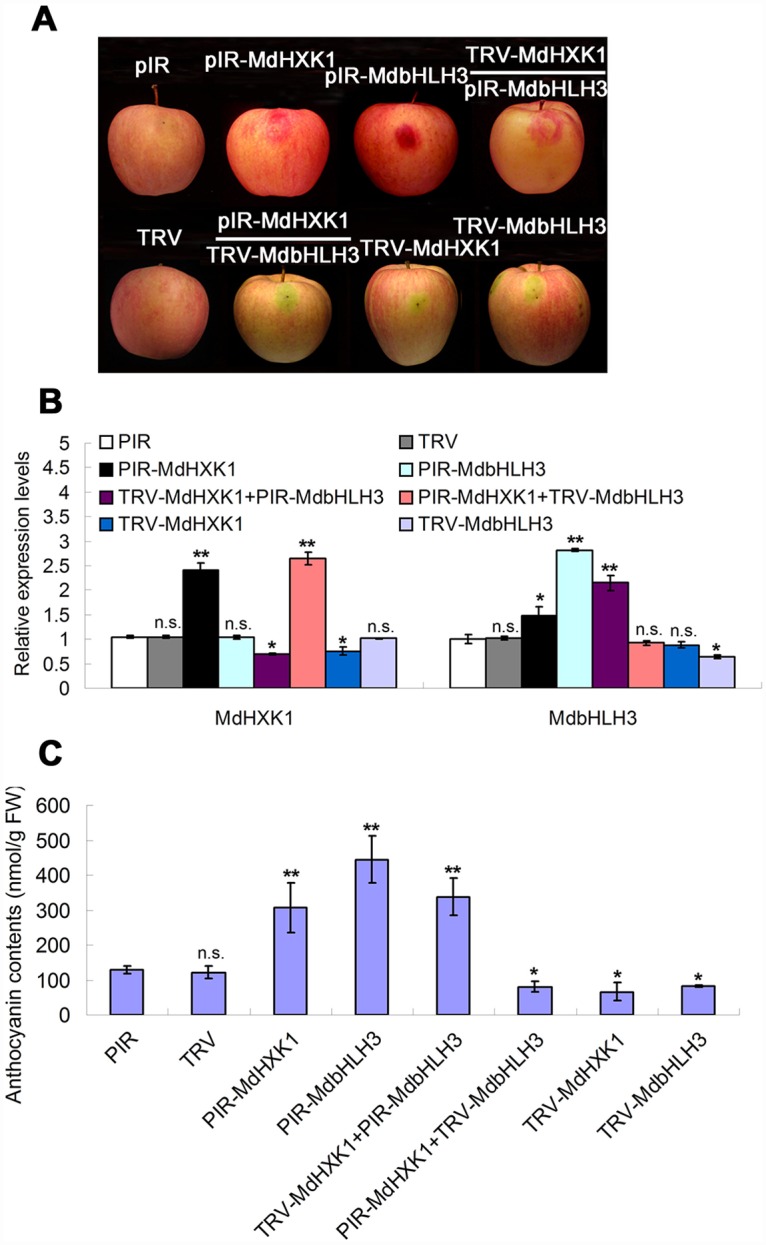
Transient expression of MdHXK1 and MdbHLH3 via the viral vector-based transformation alters anthocyanin levels in apple fruits.(A) Apple fruit peel coloration around the injection sites. The full-length cDNA of MdHXK1 and MdbHLH3 genes were cloned into the pIR vector for overexpression, whereas their antisense cDNA fragments were inserted into the TRV vector for suppression. The empty vectors were used as controls. (B) The qRT-PCR analysis of the relative expression levels of MdHXK1 and MdbHLH3 genes around the injection sites. (C) Anthocyanin content of the injected apple fruit peel in (A). In (B) and (C), the data are shown as the mean ± SE, which were analyzed based on more than 9 replicates. Statistical significance was determined using Student’s t-test in different apple calli lines. n.s., P > 0.01; *P < 0.01; **P < 0 .001.